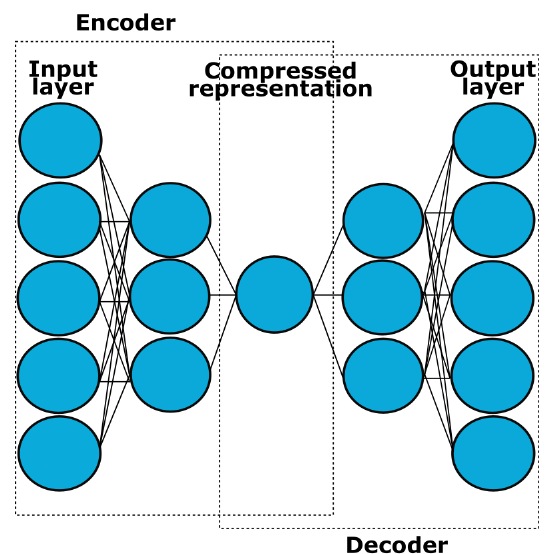
Figure 1. The general architecture of an